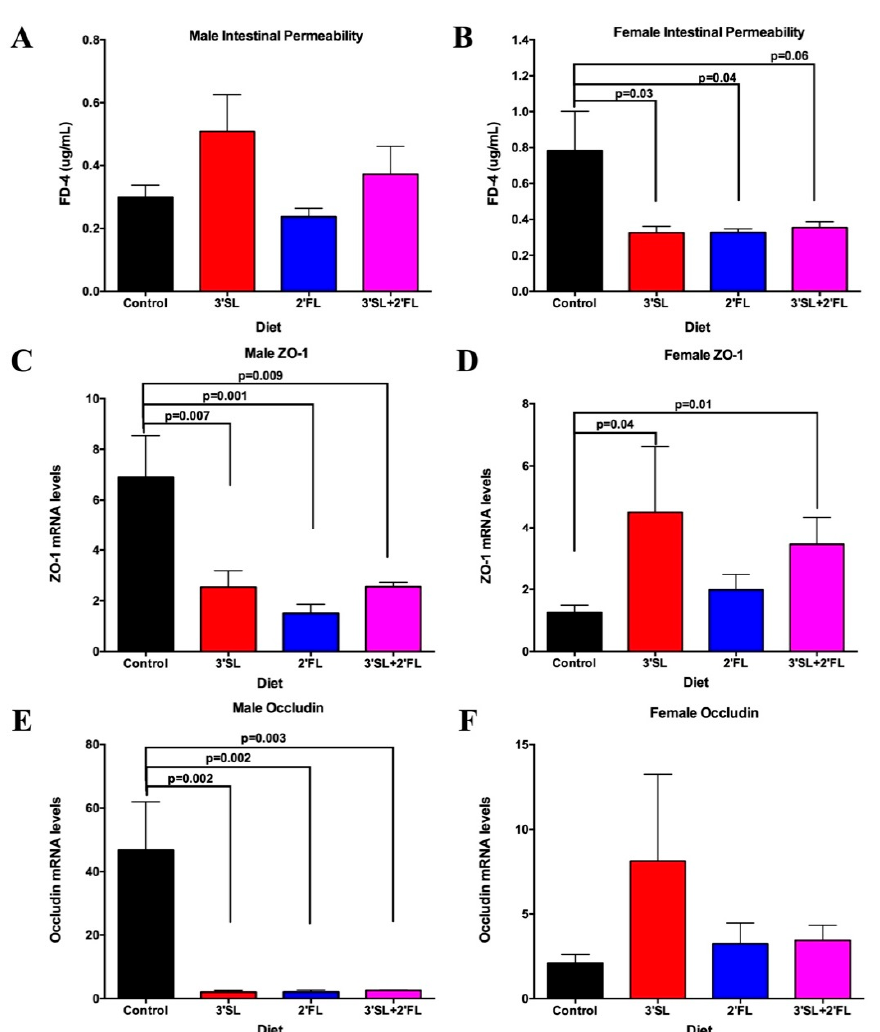
Figure 3. Intestinal permeability and jejunum mRNA levels. Plasma concentrations of fluorescein isothiocyanate (FITC) dextran 4000 (FD4) in ( A ) male and ( B ) female rats, as well as jejunum mRNA levels in ( C ) male zonula occluden-1 (ZO-1), ( D ) female ZO-1, ( E ) male occludin, and ( F ) female occludin in rats fed the AIN-93 diet fortified with 3 (cid:48) SL, 2 (cid:48) FL, both, or neither for eight weeks. Values are means ± SEM, n = 8–10. In the overall model, there was a significant sex e ff ect for IPT ( p = 0.03), ZO-1 ( p = 0.001), and occludin ( p = 0.0002); therefore, subsequent analysis was performed in males and females separately. Control: AIN-93; 3 (cid:48) SL: AIN-93 + 3 (cid:48) sialyllactose; 2 (cid:48) FL: AIN-93 + 2 (cid:48) fucosyllactose; 3 (cid:48) SL + 2 (cid:48) FL: AIN-93 + 3 (cid:48) sialyllactose + 2 (cid:48) fucosyllactose. Significance was set at p <